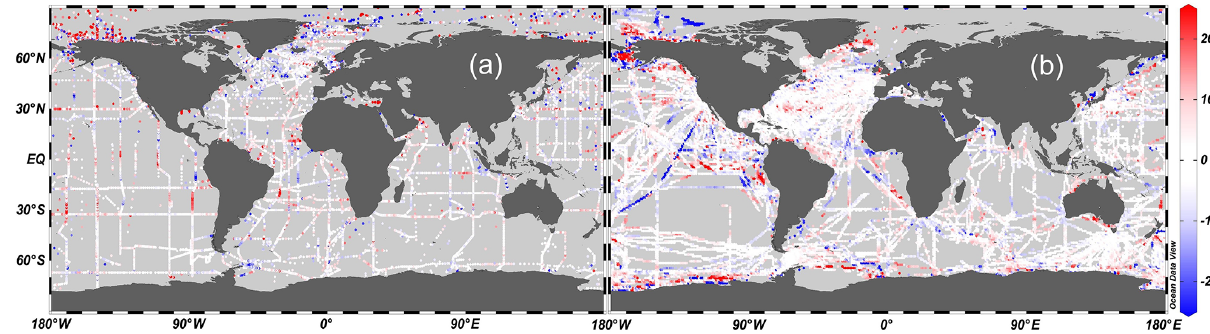
Figure 3. Differences between (a) Gv2 TCO 2 and NNGv2LDEO TCO 2 (0–30m) and (b) LDEO TCO 2 and NNGv2LDEO TCO 2 (0m). This figure was made with Ocean Data View (Schlitzer,